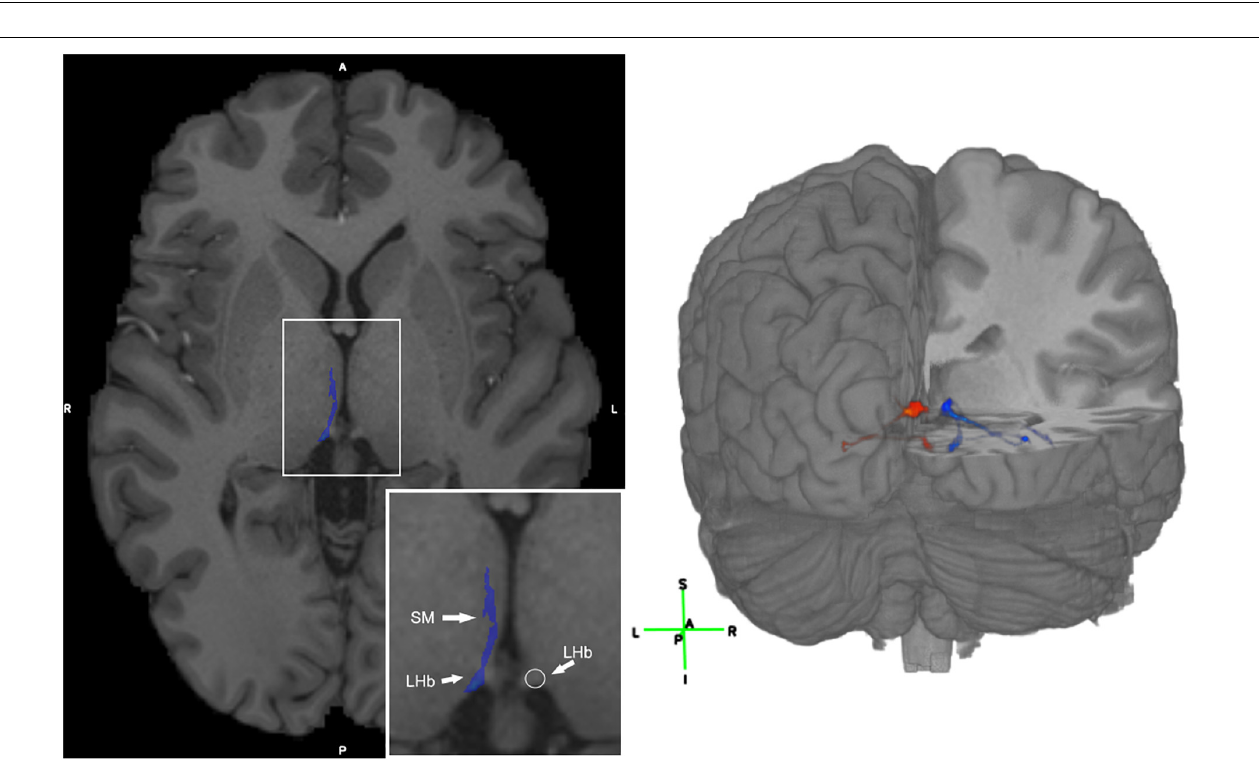
Frontiers in Neuroscience |